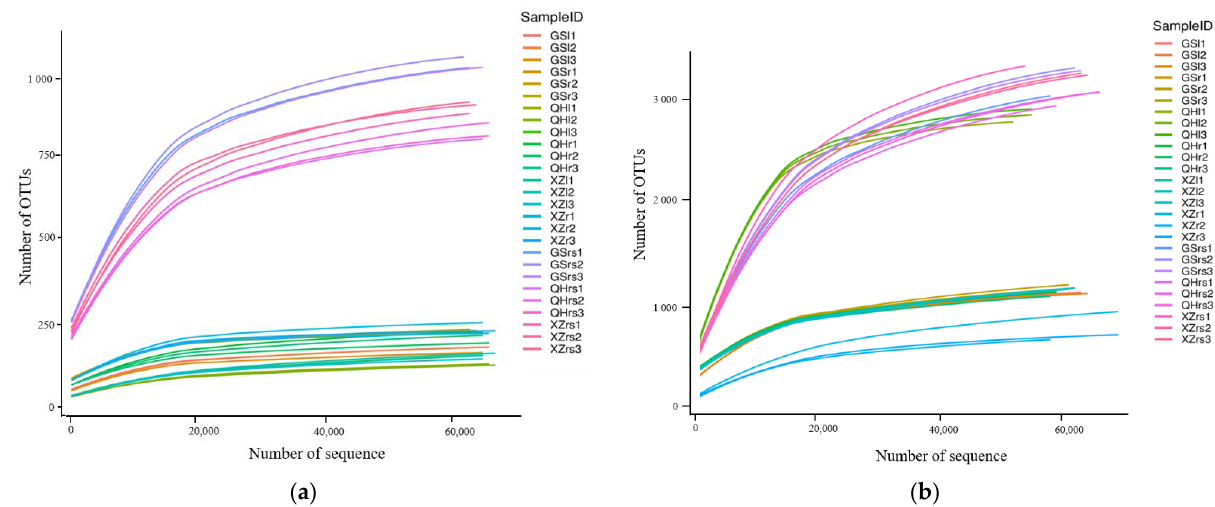
Figure 3. Rarefaction curve of fungal ( a ) and bacterial ( b ) communities. Table 1. Diversity index of fungal and bacterial communities associated with S . purpurea.